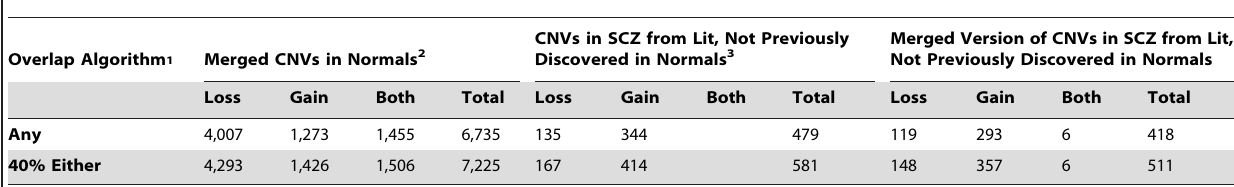
Table 1. Number of CNVs in Normal and SCZ databases based on the literature, by overlap algorithm.